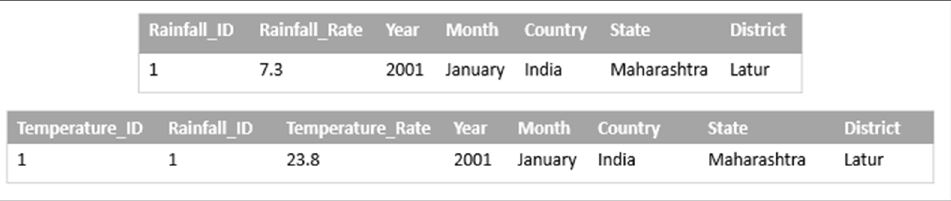
Figure 4. Rainfall and temperature relational tables.